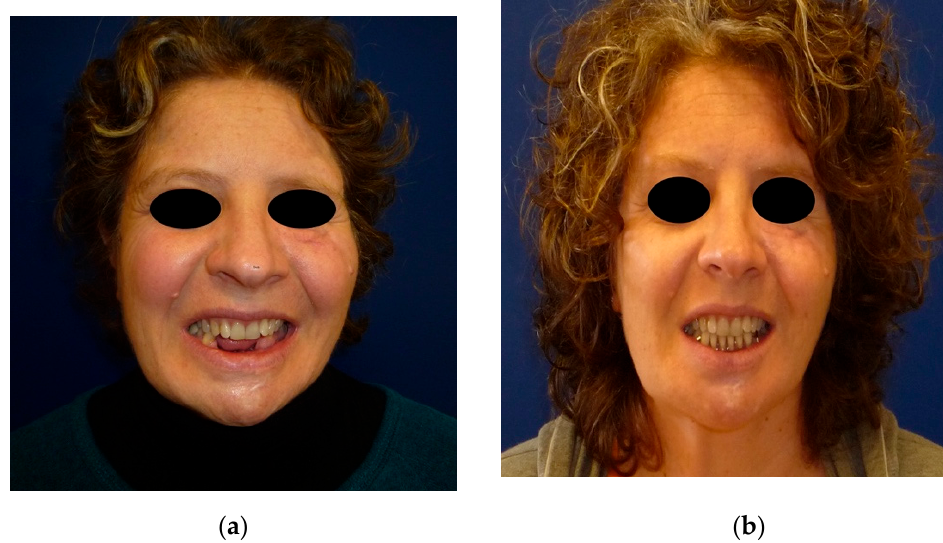
Figure 1. A 41-year-old female patient wounded by a low-velocity injury weapon. ( a ) Before prosthetic treatment; ( b ) after prosthetic treatment.